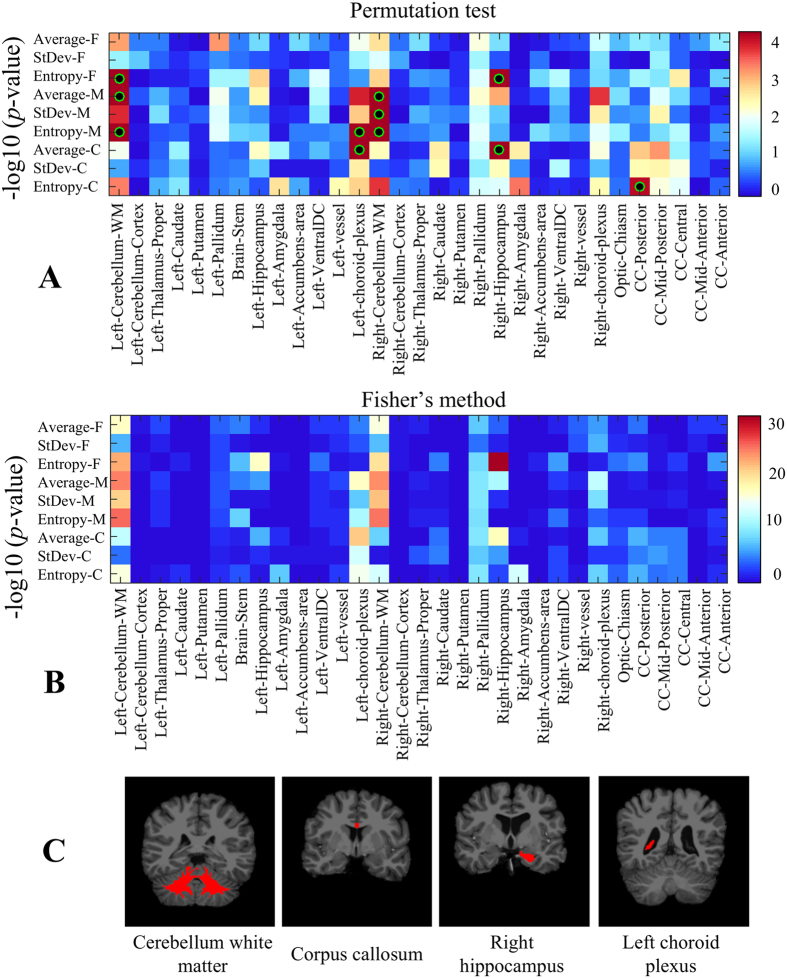
Region-wise texture feature differences between ASD and TDC subjects.(A) Heatmap of uncorrected p-values (−log10 space), based on 100,000 permutations of diagnosis group labels. Green-black circles indicate region-scale values with significant p-values following Holm-Bonferroni correction. (B) Heatmap of Fisher’s method p-values (−log10 space), based on 100 bootstrap samples of 100 ASD vs 100 TDC subjects. (C) Regions showing significant texture differences with corrected p < 0.05.